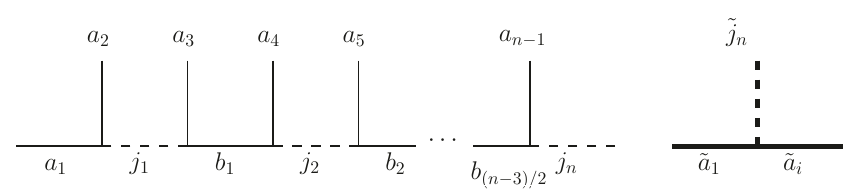
( I 1 , n, i ) in the DDM basis. Notice that n || n